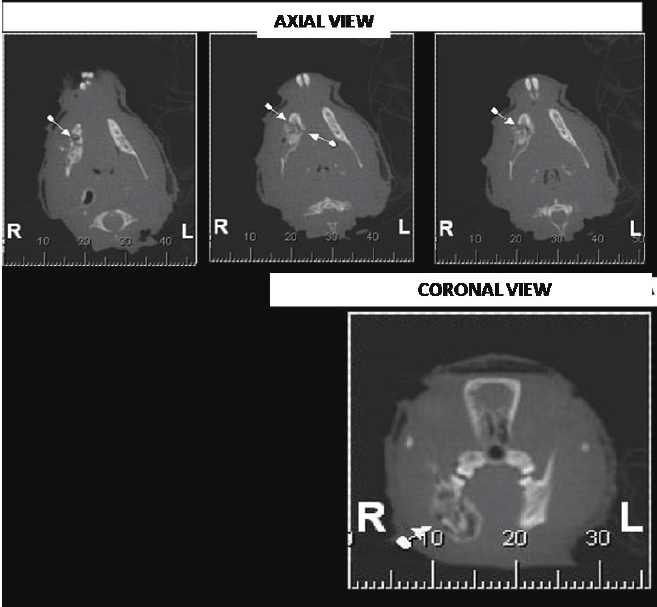
FIGURE 2 – CT scan of the experimental group at 21 days (the white arrows show the fracture